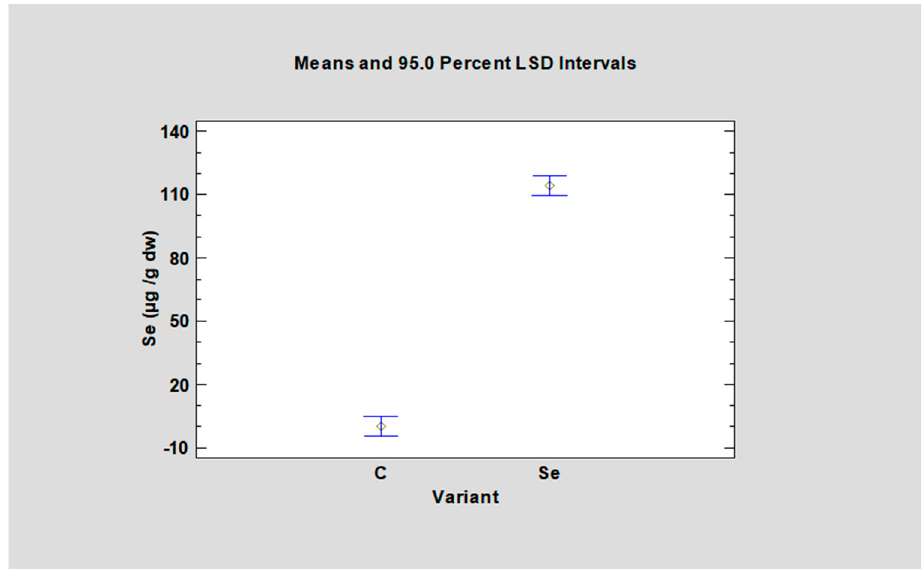
Figure 5. Selenium content (dw—dry weight) in all tested microgreens species after fortification with sodium selenate. C—control variant; SeAp—selenium application (2 mg Se/L).